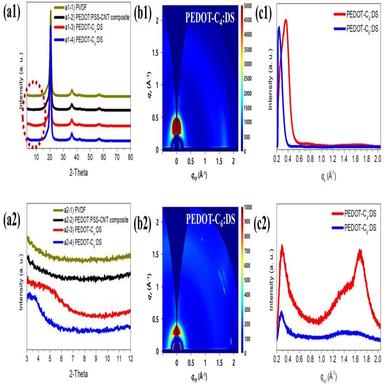
XRD spectra of PVDF, PEDOT:PSS-CNT composite, PEDOT-C4:DS and PEDOT-C6:DS on PVDF (a); from 3° to 80° (a1), from 3° to 12° in red-dot circle (a2). 2D-GIWAX images of PEDOT-Cx:DS films on Si substrates (b); PEDOT-C4:DS (b1) and PEDOT-C6:DS (b2). Corresponding line cut profiles of the 2D-GIWAX images (c); out-of-plane linecuts (c1) and in-plane linecuts (c2). (For interpretation of the references to color in this figure legend, the reader is referred to the web version of this article.)